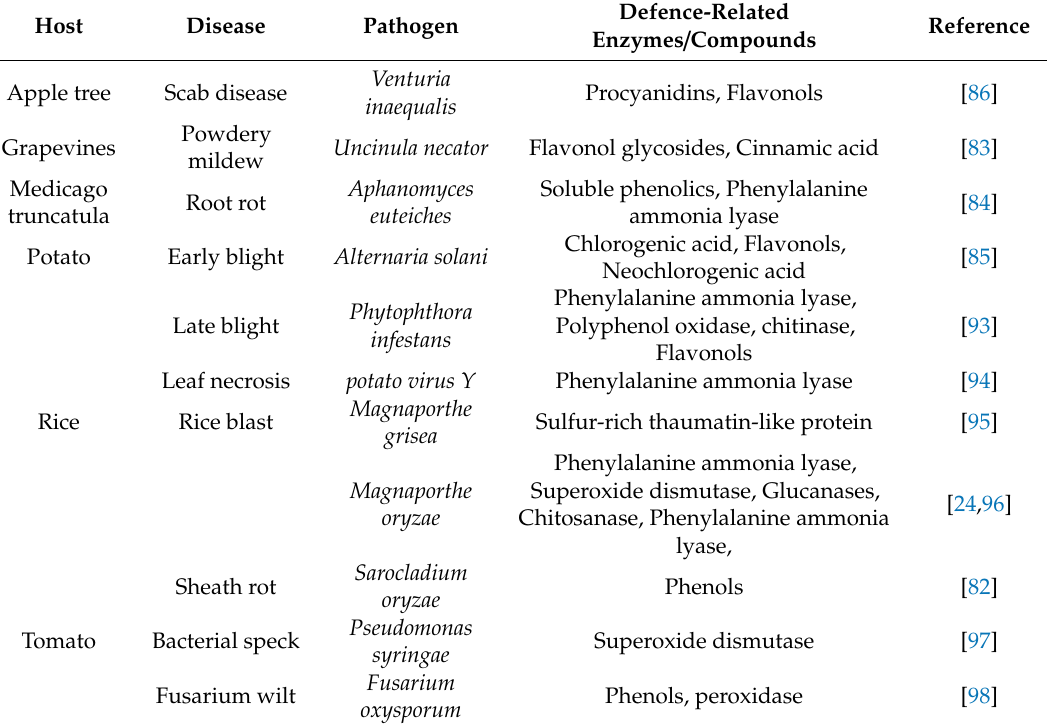
Table 2. Defence-related enzymes or compounds regulated by nitrogen during plant disease